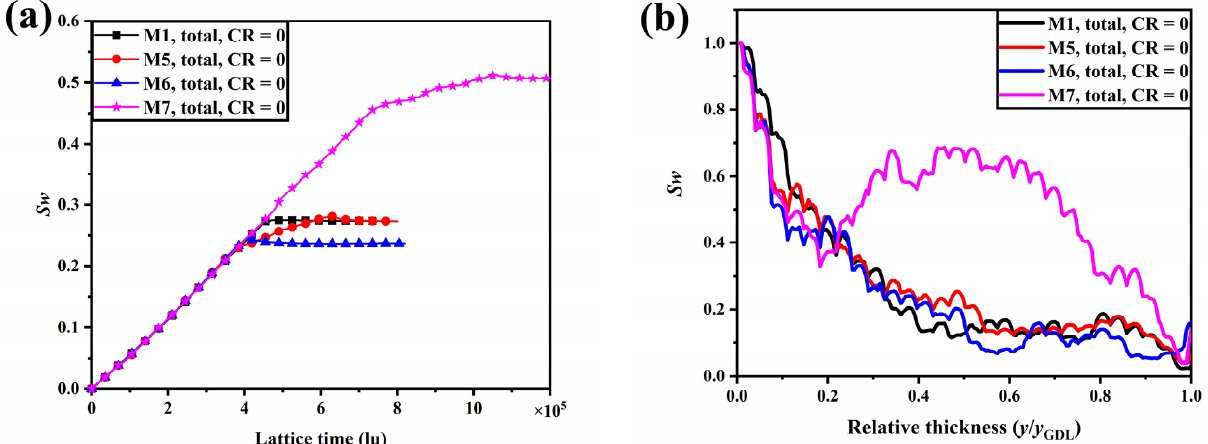
Figure 6. ( a ) The evolution of water saturation within M1, M5, M6, and M7 with time; ( b ) the distribution of water saturation along the through-plane direction as liquid water reaches the steady state within M1, M5, M6, and M7.